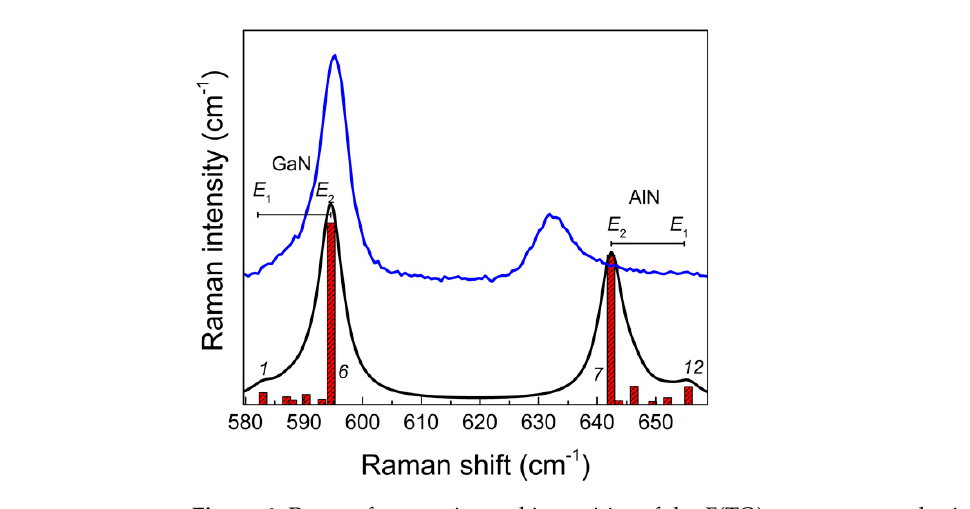
Figure 5. Calculated ( a ) and experimental ( b ) Raman spectra of (GaN) m /(AlN) n SLs in the 𝑧(cid:4666)𝑥𝑦(cid:4667)𝑧̅ scattering geometry in the region of E (TO) modes, m / n : 1— 4/4, 2 —6/6, 3 —8/8.